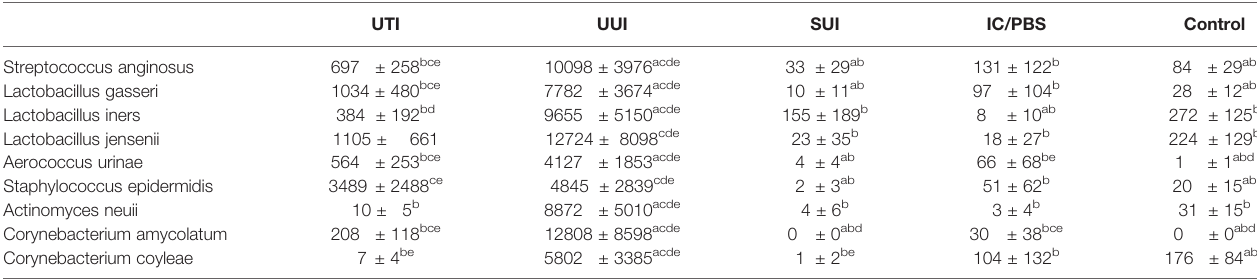
TABLE 6 | Age adjusted mean (CFU/mL) ± standard error